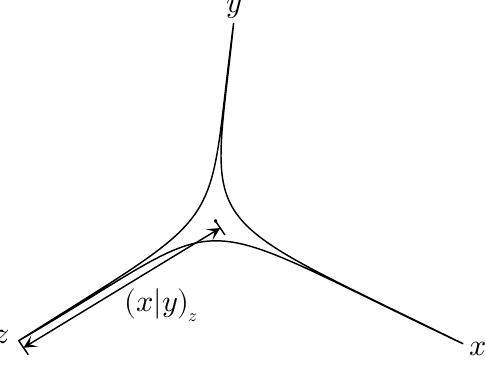
Figure 5: Approximate value of the Gromov product in a δ -hyperbolic